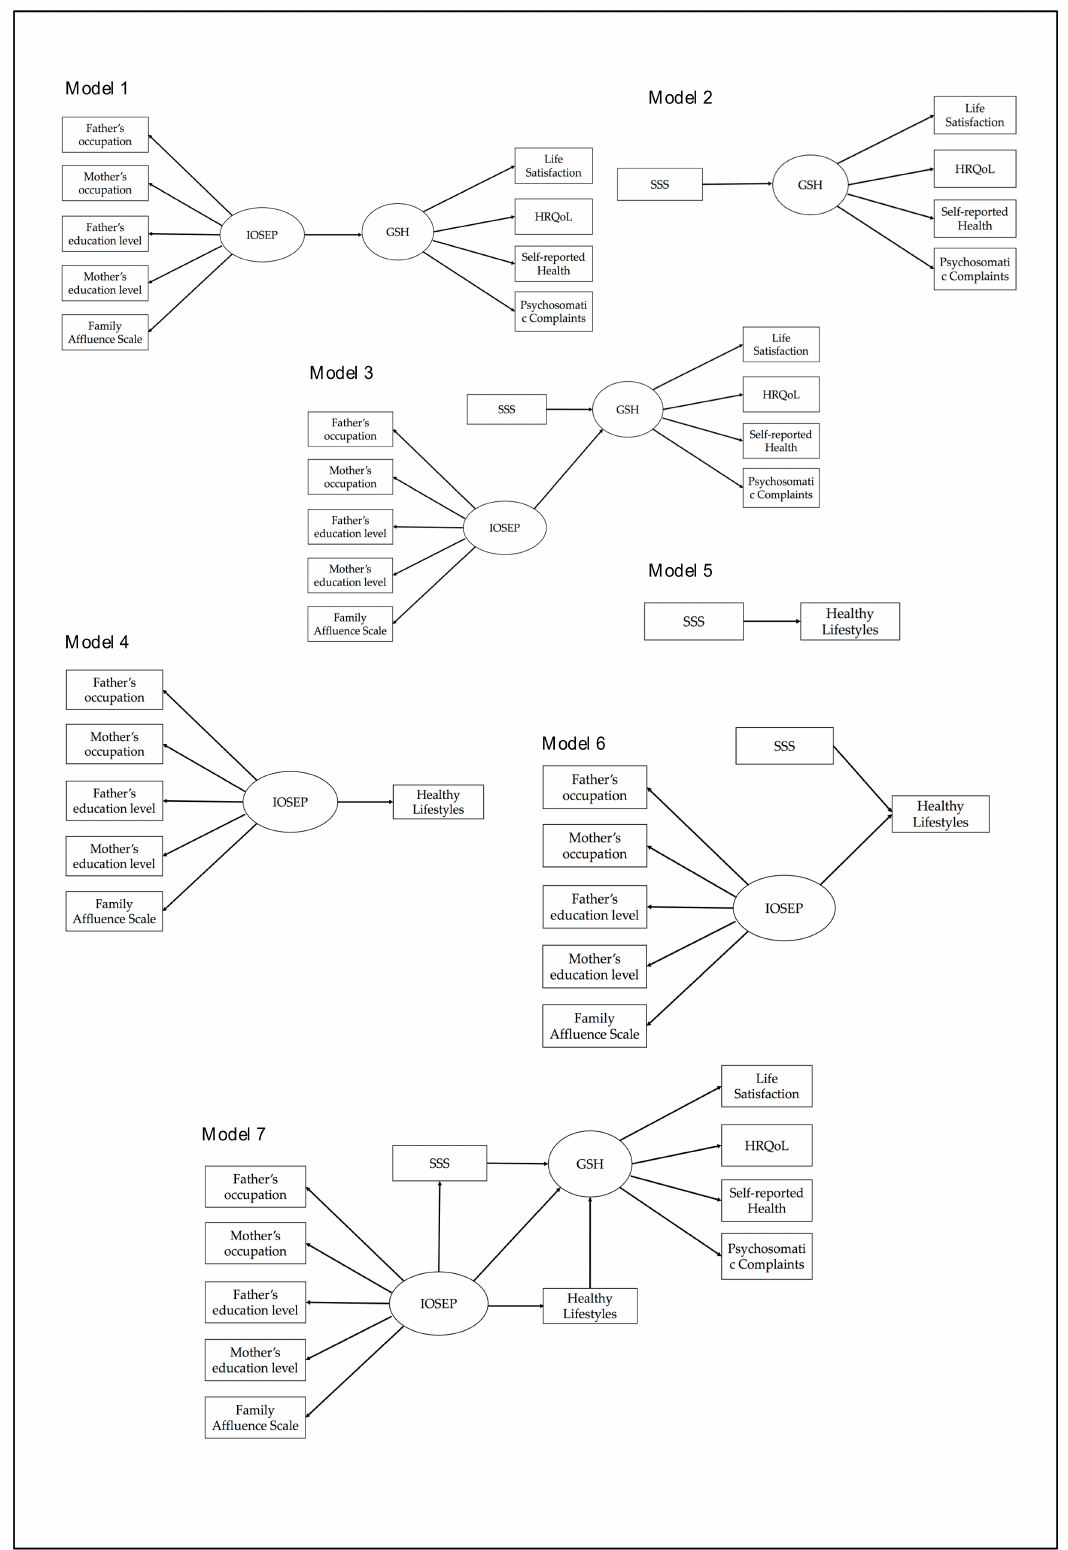
Figure 1. The hypothesized models. IOSEP, index of objective socioeconomic position; SSS, subjective socioeconomic status; GHS, global health score; HRQoL, health-related quality of